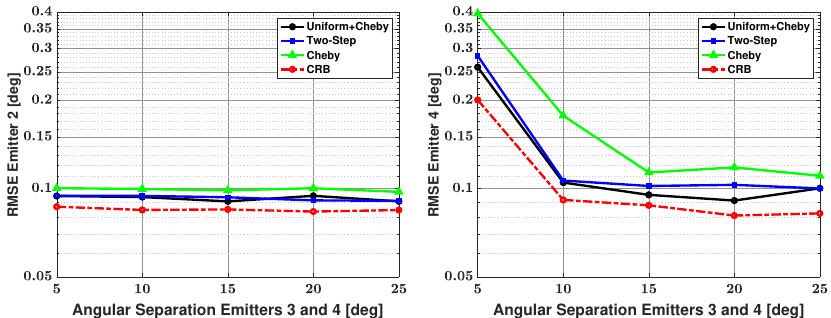
Figure 11. RMSE in the estimated direction versus angular separation between emitters #3 and #4: emitter #2 ( left ) and emitter #4 ( right ); the three proposed methods are used for estimation; SNR of emitter #1 = 18 dB, emitter #2 = 5 dB, emitter #3 = 25 dB, and emitter #4 = 0 dB, respectively; 100 snapshots; and 500